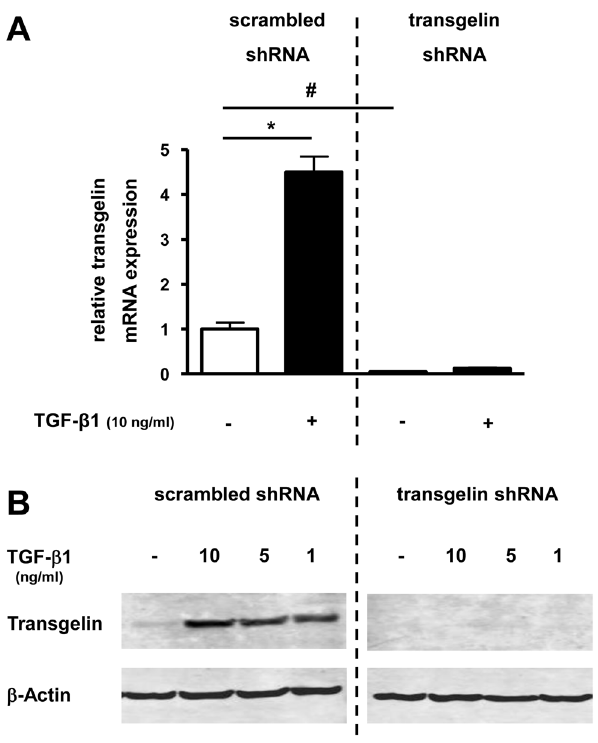
Figure 5. Effect of transgelin-specific shRNA on basal and TGF- b 1 mediated induction of transgelin mRNA- and protein- expression in lung epithelial cells. Transgelin was down-regulated by transgelin-specific shRNA (right side; ‘‘transgelin shRNA’’) compared with control cells, which were expressing non-specific shRNA (left side; ‘‘scrambled shRNA’’). A549 cells were then cultured in serum reduced medium (0.2% FCS) for 24 h before treatment with TGF- b 1. Total RNA and protein was isolated after incubation with TGF- b 1 in different concentrations. Transgelin mRNA and protein levels were detected by real time-PCR (after 24 h) (A) or by Western blot analysis (after 48 h) (B), respectively. Means 6 SD of at least n=3 independent experiments are shown. In B, a representative immunoblot of at least three independent experiments is shown. * p , 0.05 compared to control cells, # , 0.05 compared to ‘‘scrambled